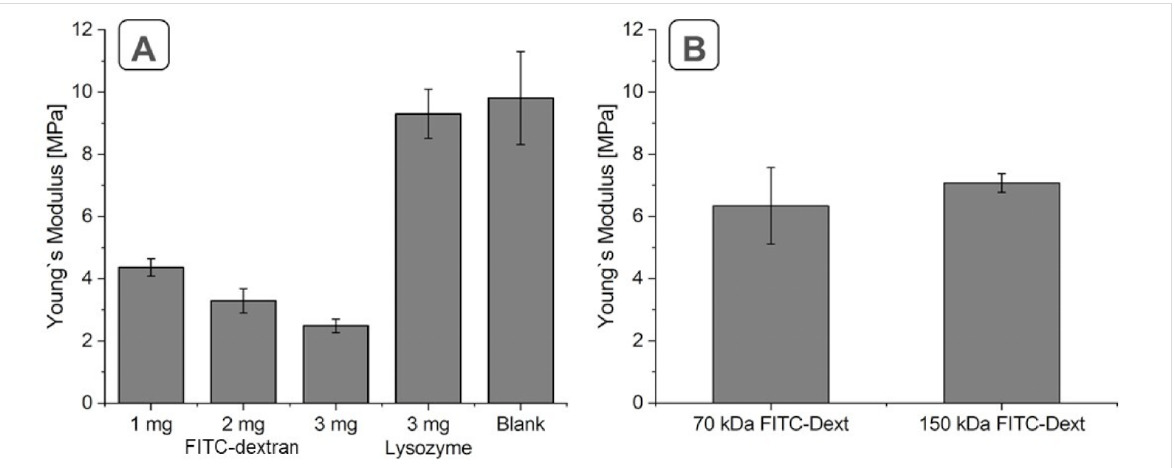
Figure 3: Influence of loading on the resulting particle elasticity. (A) FITC-dextran 70 kDa and lysozyme loading at different initial amounts after 2 h of crosslinking. (B) Loading of FITC-dextran with different molecular weight in the same mass concentration after 3 h of crosslinking.